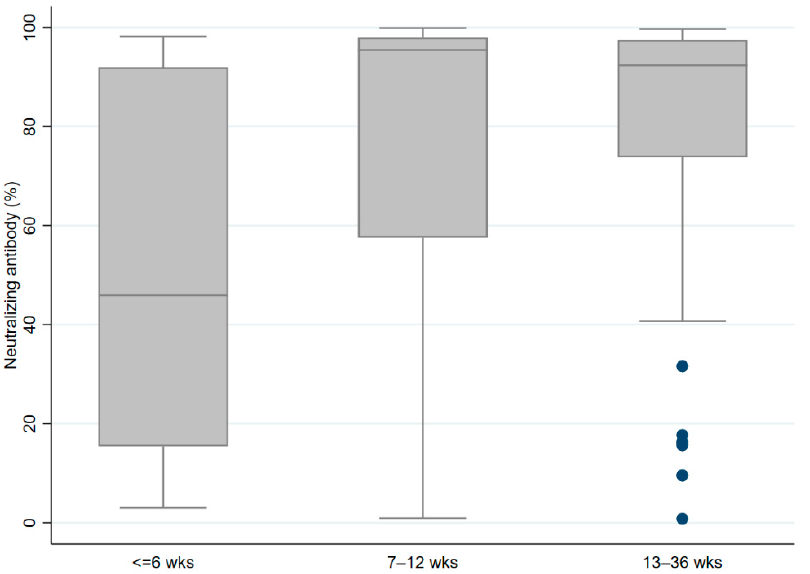
Figure 2. Boxplot comparing the COVID-19 neutralizing antibody percentage between the partici-